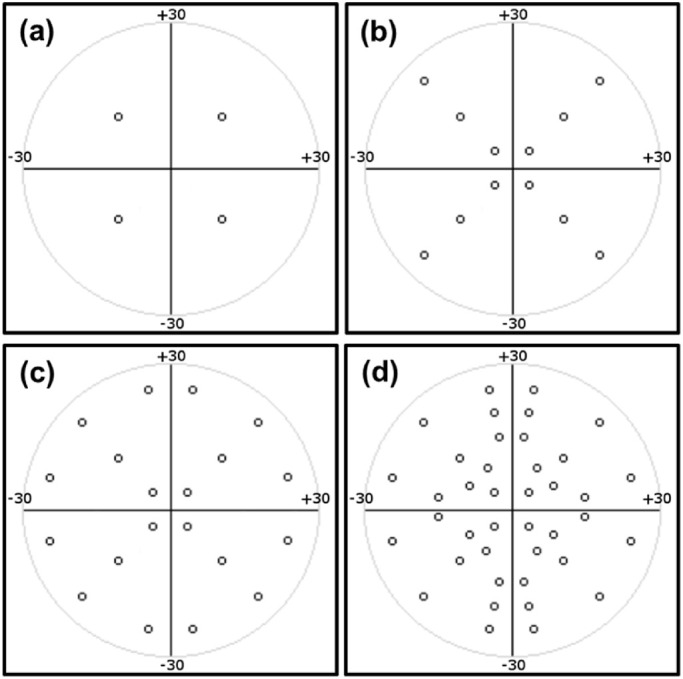
The 4-, 12-, 20-, and 40-point test patterns. The 40-point pattern is equivalent to the HFA C-40 pattern including points at 5°, 10°, 20°, and to 25° of eccentricity.